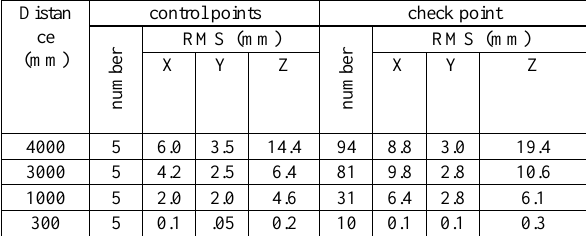
Table 2 evaluating the accuracy of determining the coordinates of object